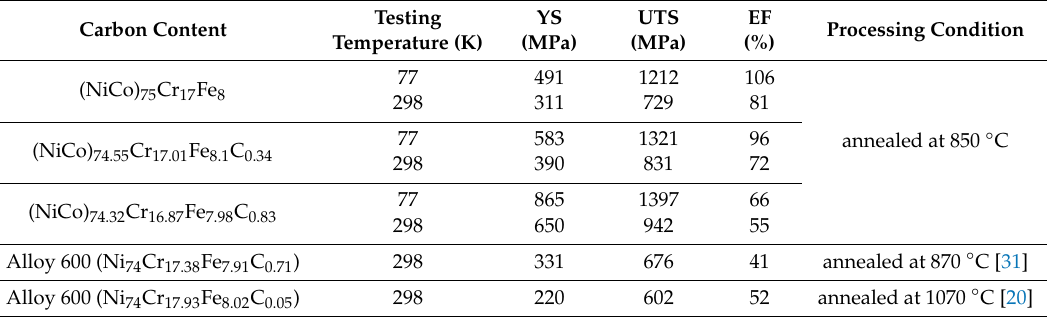
Figure 6. Stress-strain responses of (NiCo) 75 Cr 17 Fe 8 C x alloys at room and cryogenic temperatures. Table 2. Tensile mechanical properties of the (NiCo) 75 Cr 17 Fe 8 C x of the present study along with the data of Alloy 600 for comparison.